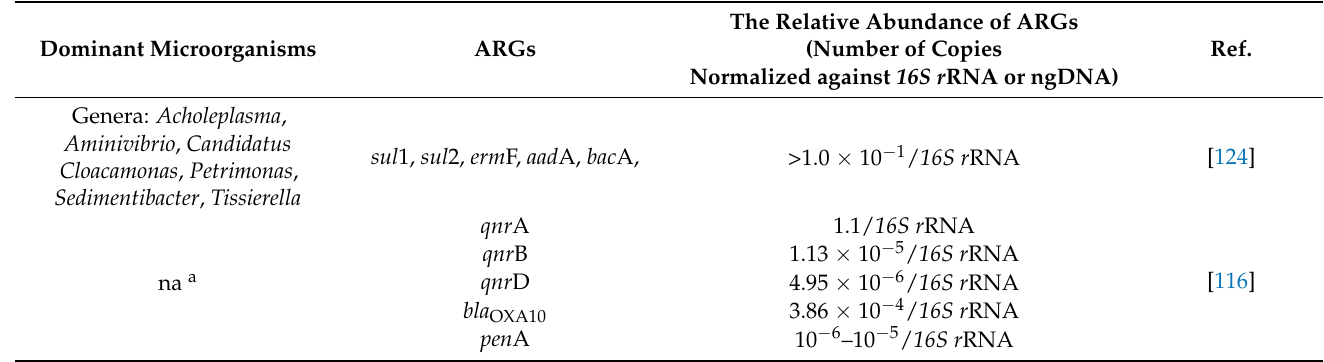
Table 7. Types of ARGs detected in landfill